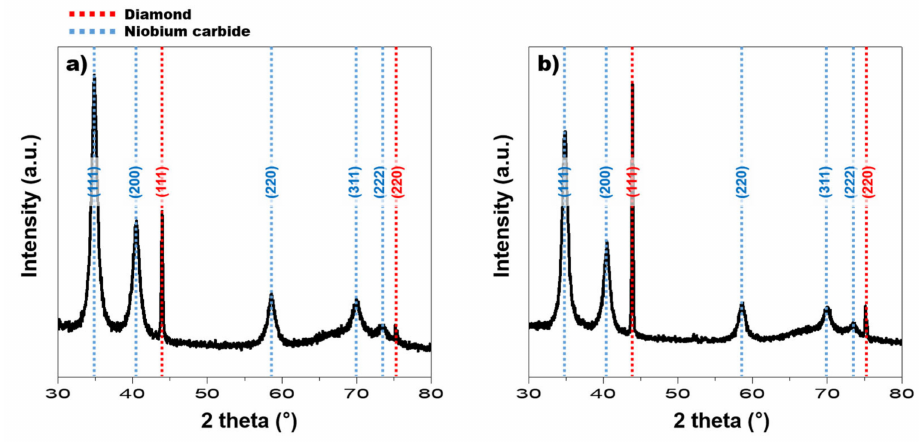
Figure 3. X-ray di ff raction analysis results with respect to deposition time: ( a ) 12 h and ( b ) 60 h.